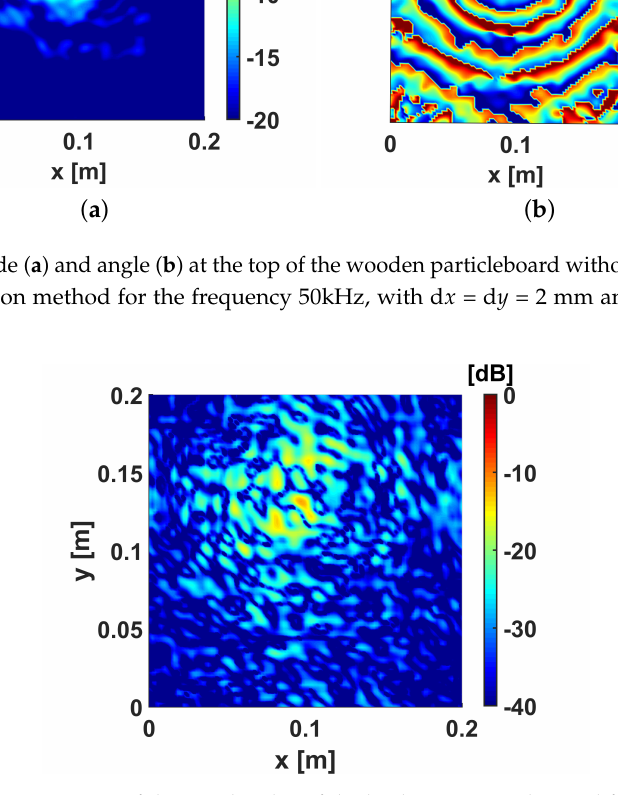
Figure 6. Difference image DI of the amplitudes of the back propagated sound field of the spec- and re-radiation